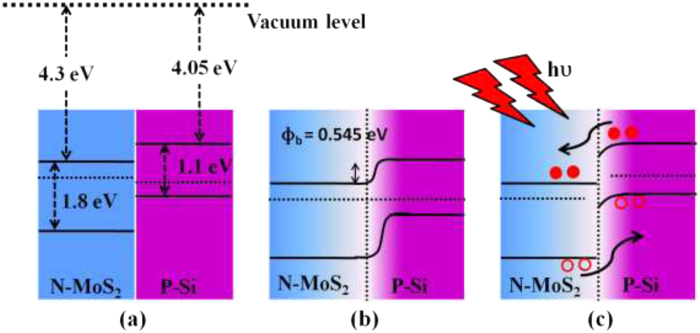
(a) Band edge alignment of Si/MoS2 heterostructure and band diagram of MoS2-Si heterojunction (b) at 0 V bias (c) at reverse bias.